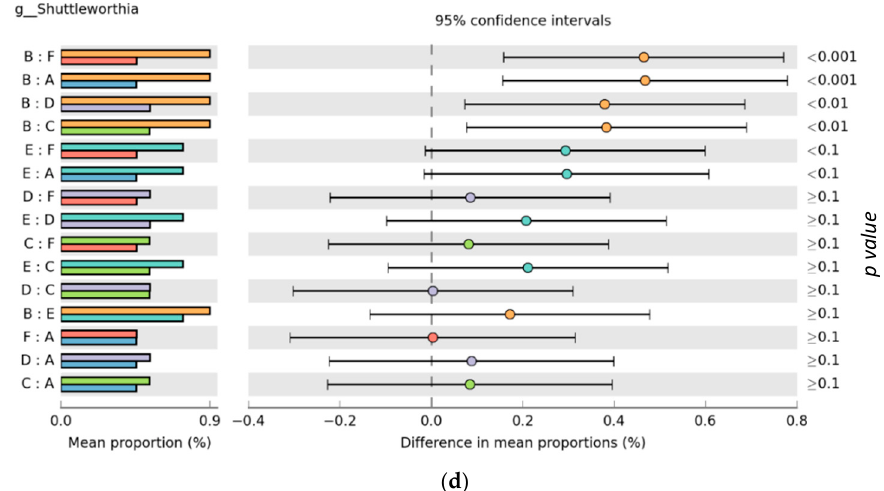
Figure 5. Significant differences (ANOVA, B–H FDR corrected p value: p < 0.05) in cumulative proportions of genus ( a ) Christensenellaceae_R-7 _group, ( b ) Elsenbergiella , ( c ) Lachnoclostridium , and ( d ) Shuttleworthia in ceca microbiota of broiler chickens subjected to different treatments groups.